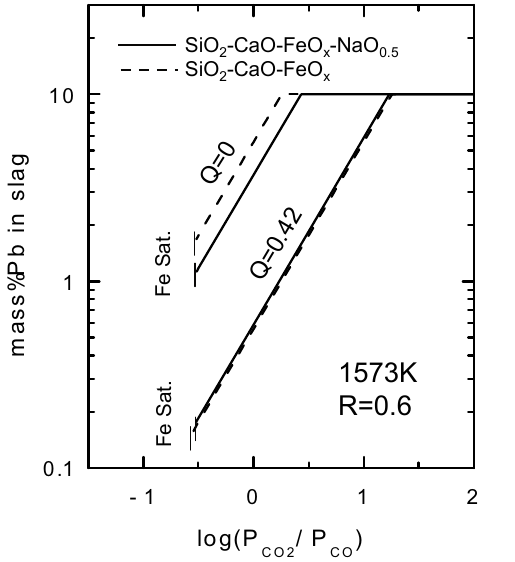
Figure 9. Lead content in CaO-SiO 2 -FeO x -NaO 0:5 slag as =P CO / at 1573 K. a function of log ( P CO 2